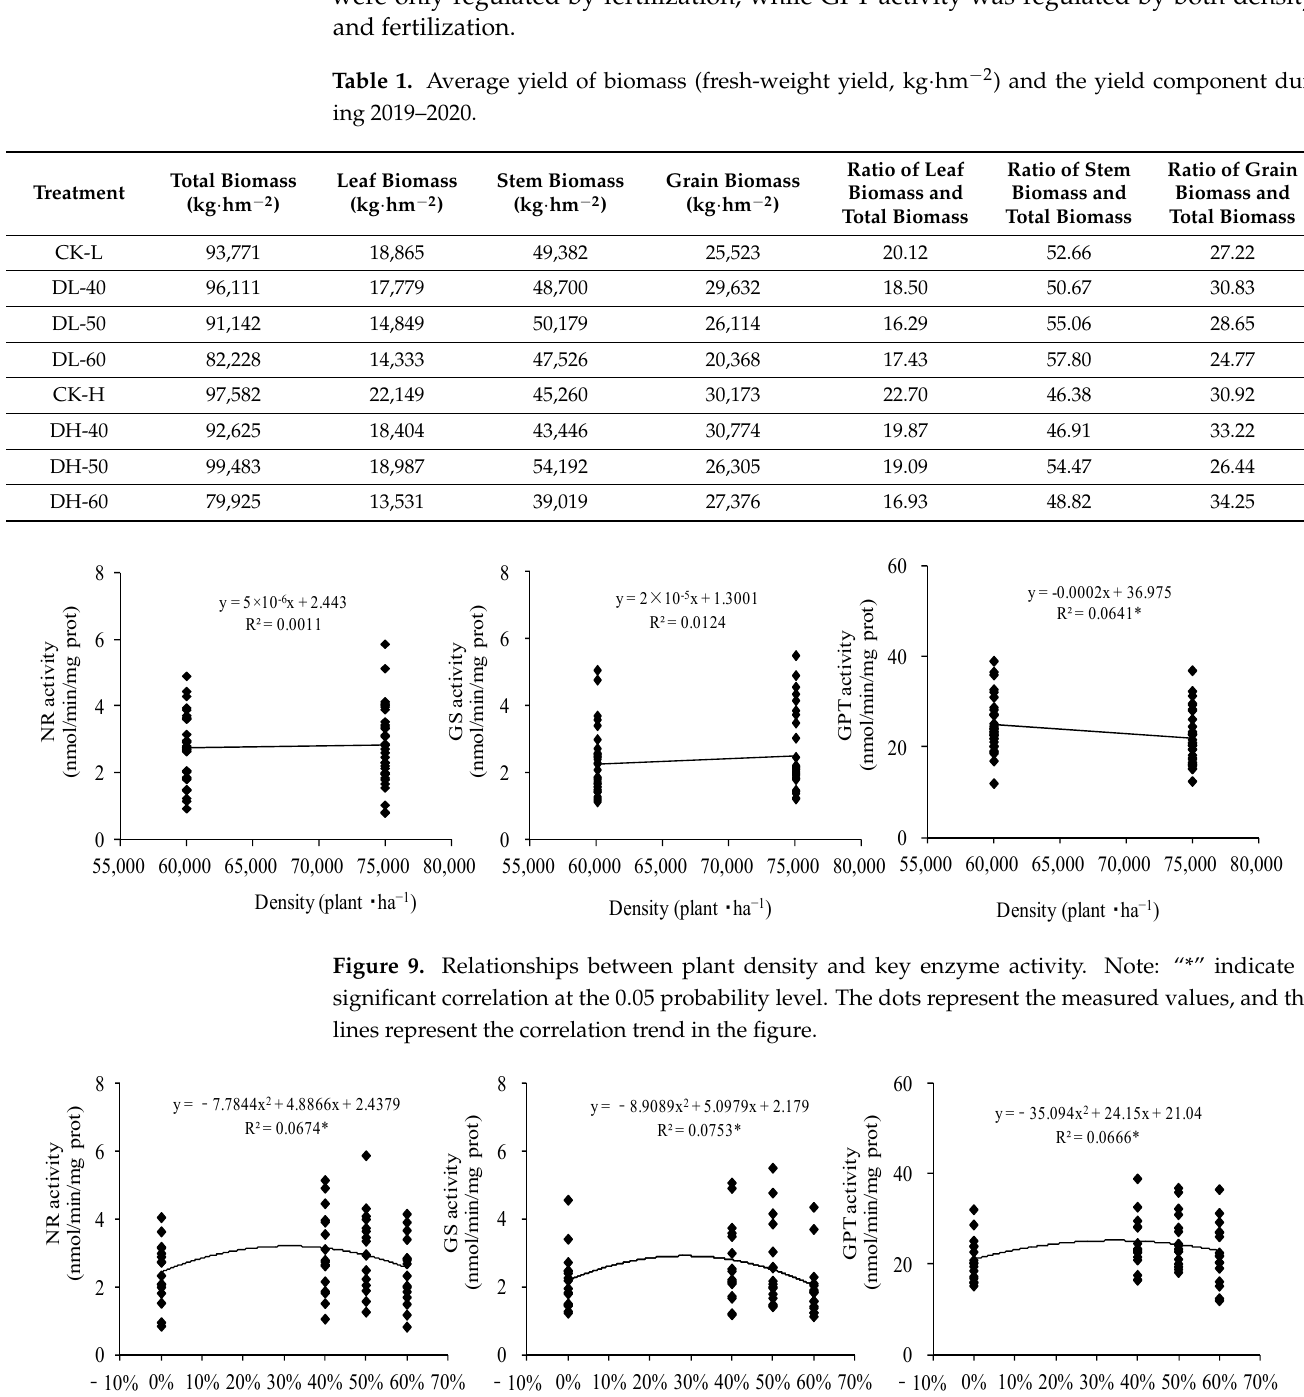
8 of 15 Figure 8. Effects of density and fertilization on the crude protein yield in organs of forage maize. Note: Different letters on bars indicate significant differences among treatments at the 0.05 proba- bility level. Table 1. Average yield of biomass (fresh-weight yield, Kg·hm − 2 ) and the yield component during